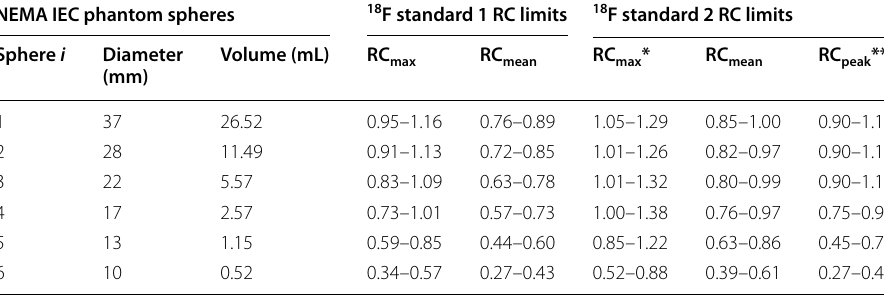
Table 1 EARL1 and EARL2 RC limits. *At the time of this work, RC under investigation. ** RC limits were under revision. Table adapted from the EARL webpage [30] peak NEMA IEC phantom